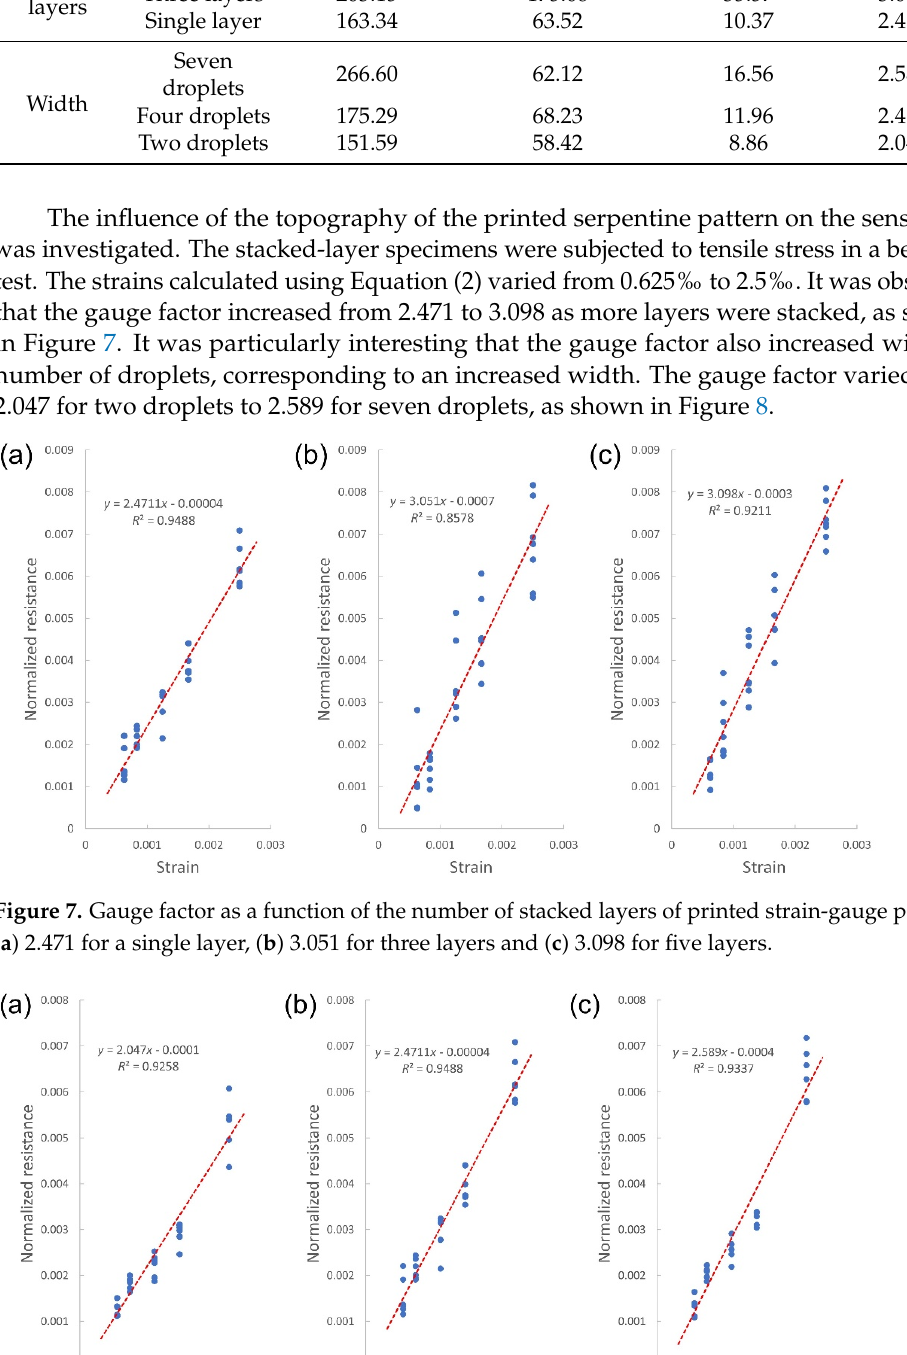
Figure 9. Gauge factor as a function of cross-sectional area of printed strain-gauge patterns. The black dots and green squares are for the width and the number of stacked layers, respectively.